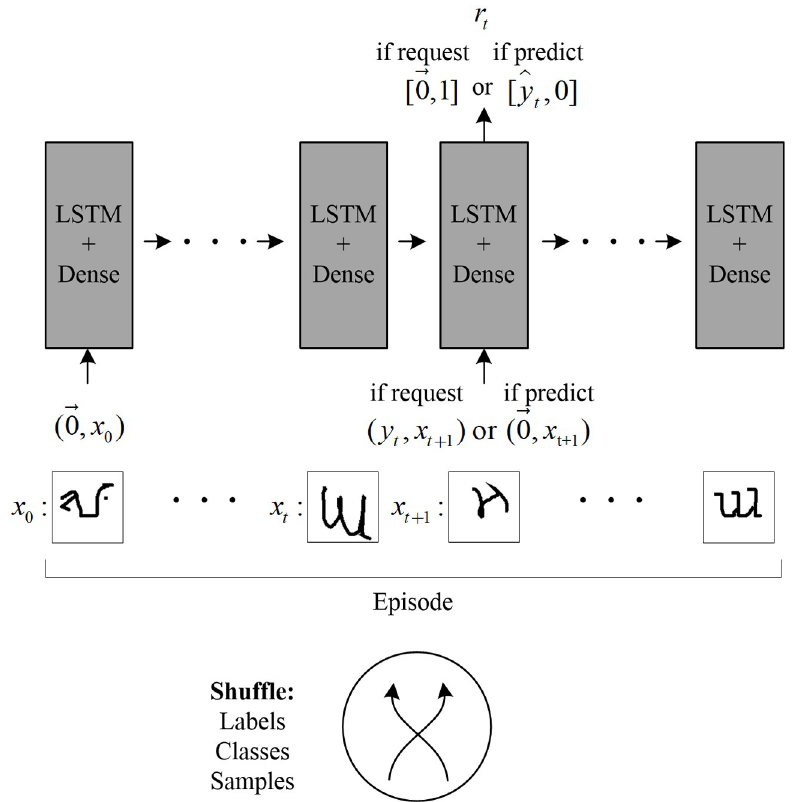
Fig 1. Task structure diagram. For images in the dataset, the classes and their labels and the specific samples are shuffled and randomly presented at each episode. At each time step, the input of the model is an image along with a vector which depends on the output of the previous instance. The output of the model is a one-hot vector of length k + 1, where k is the number of classes per episode. If the model requests the label of x vector to 1. Thus, the reward for this label request action is R next time step along with the next image x t +1 . Alternatively, if the model makes a prediction of x t , it sets one of the first k bits of the output vector, representing ^ y . The reward for this action is R cor if the prediction is correct or R inc if not. If a prediction is made at time step t , then no information regarding its true label y t is supplied at the next time step t +1.